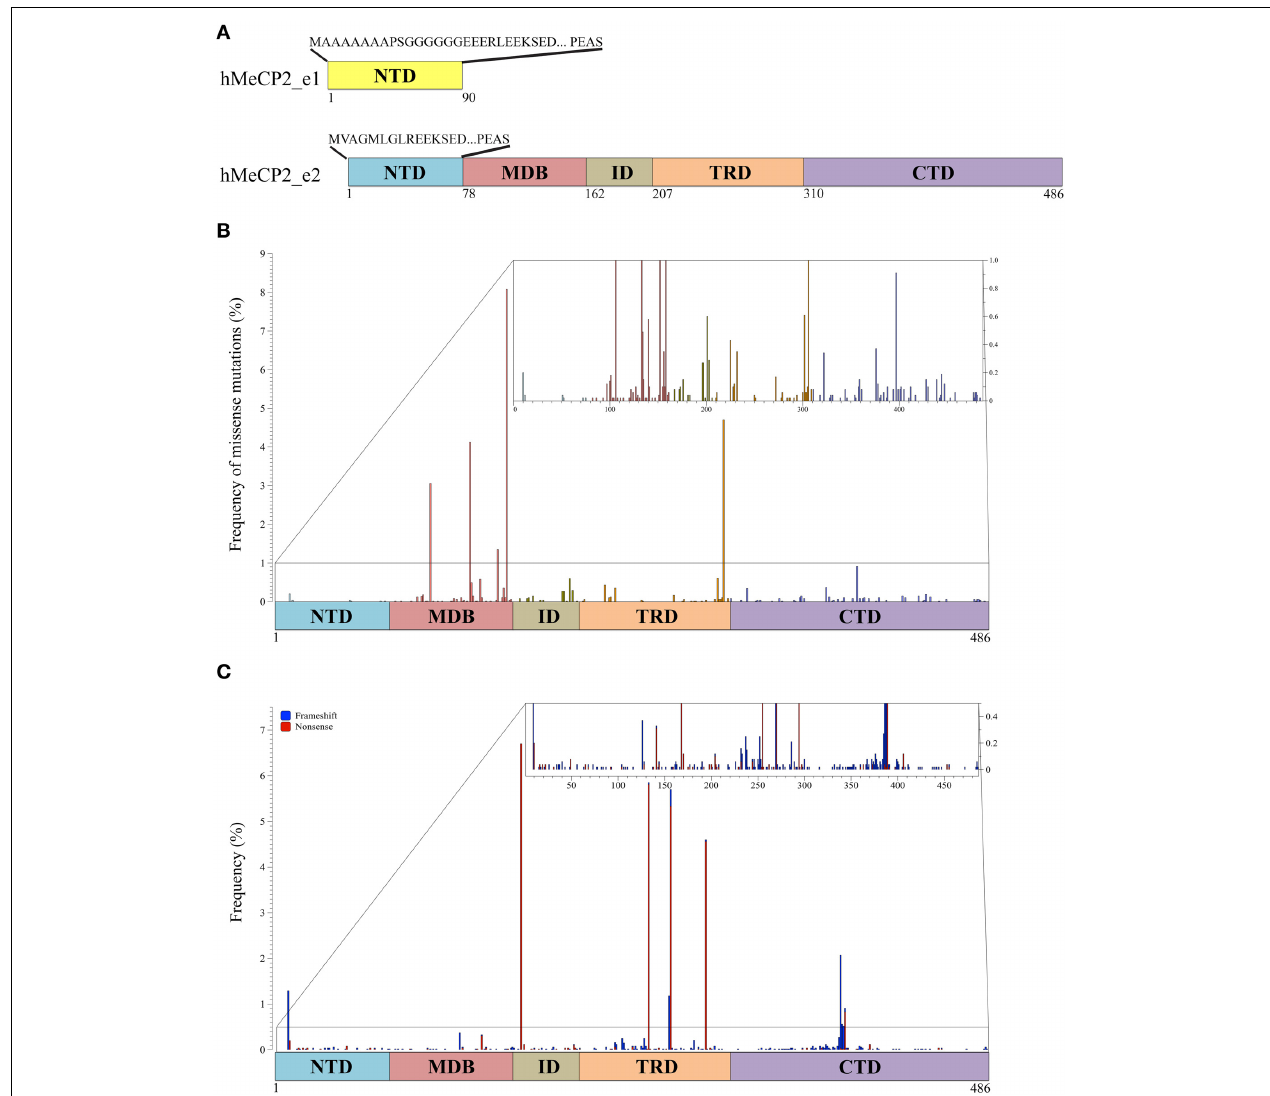
FIGURE 1 | MeCP2 isoforms and pathogenic mutations. (A) Two MeCP2 isoforms, MeCP2_e1 and MeCP2_e2, are generated by alternative splicing originating two distinct N-terminal regions. MeCP2_e1 is 498 amino acids long and contains a N-terminal domain (NTD, yellow) of 90 amino acids of which the first 21 are distinct, whereas MeCP2_e2, formed by 486 amino acids, has 9 unique amino acids in its NTD (blue). MeCP2 is constituted by five sub-domains: NTD, MBD (methyl-CpG binding domain), ID (intervening domain), TRD (transcriptional repression domain, CTD (C-terminal domain);